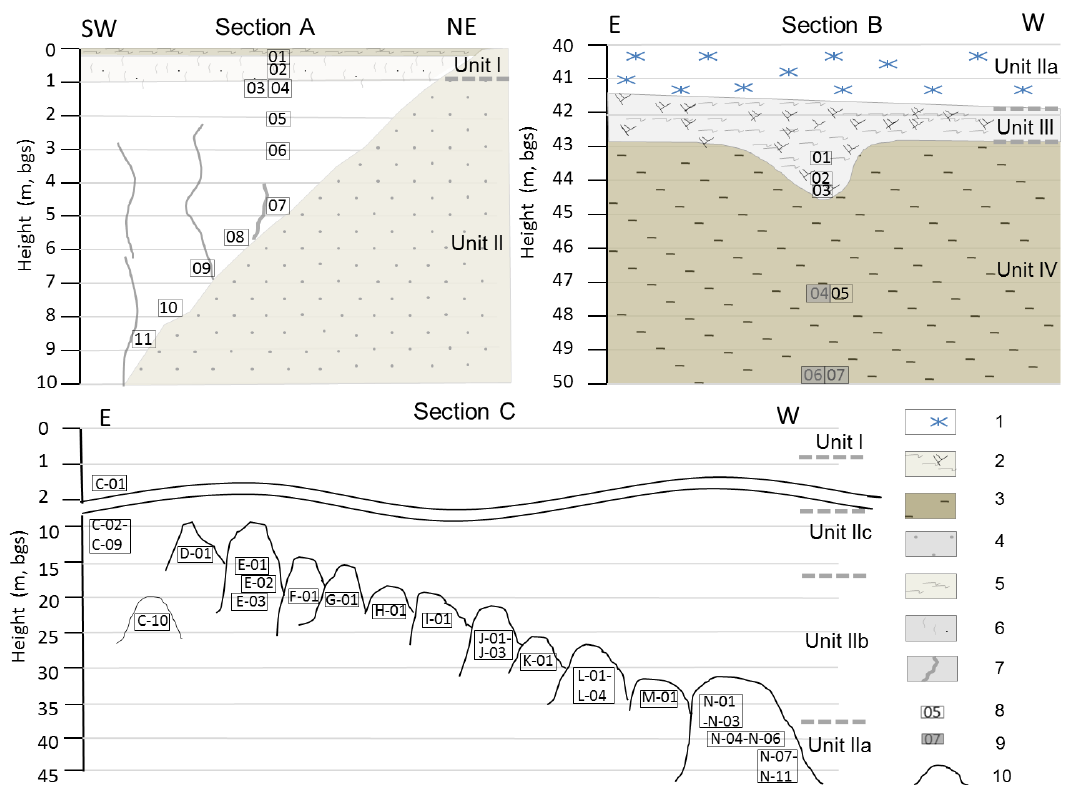
Figure 5. Sections of the Batagay permafrost exposure include the following: 1 – ice-rich sediments, 2 – organic layer with plant remains, 3 – layered cryostructure, 4 – sand, 5 – plant detritus, 6 – active layer with roots and coal, 7 – ice wedge, 8 – sediment and macrofossil sample site, 9 – OSL and sediment sample site, and 10 – baidzherakh